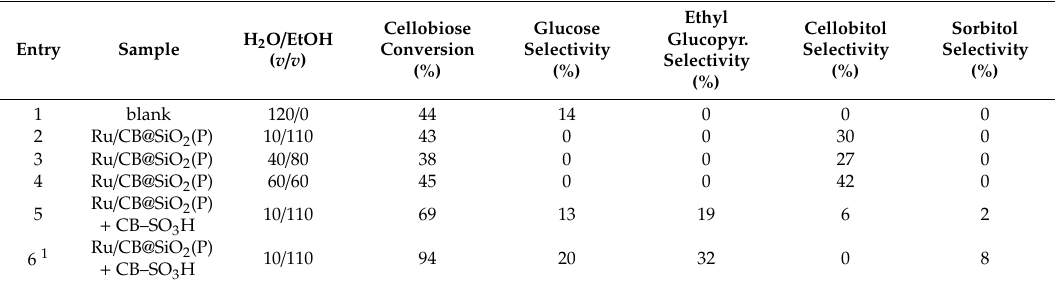
Table 3. Conversion and selectivity for the hydrogenation and hydrolysis of cellobiose at 150 ◦ C for 2 h under 30 bars of pure